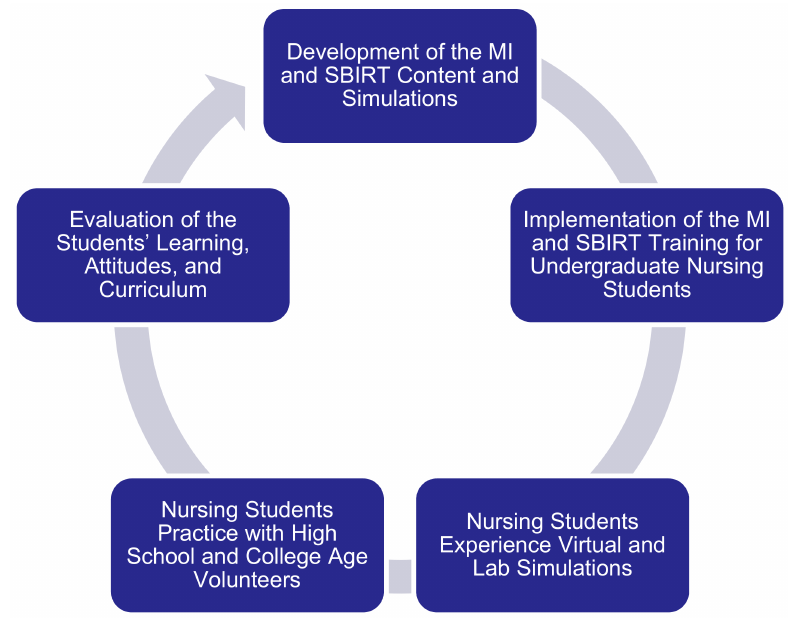
Figure 1. Process for implementation of the motivational interviewing (MI) and SBIRT (Screening, Brief Intervention, Referral to Treatment)